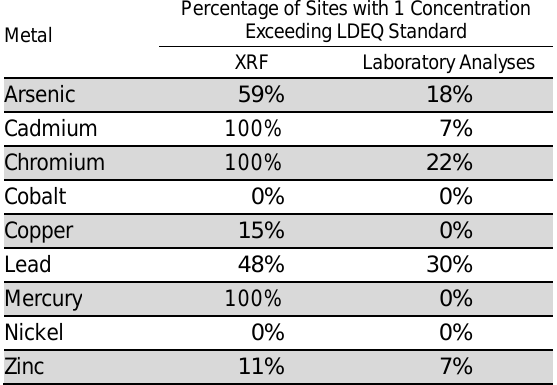
Table 2. Percentage of Sites that had at Least 1 Reported Concentration Above the LDEQ Standard by Method of Analysis